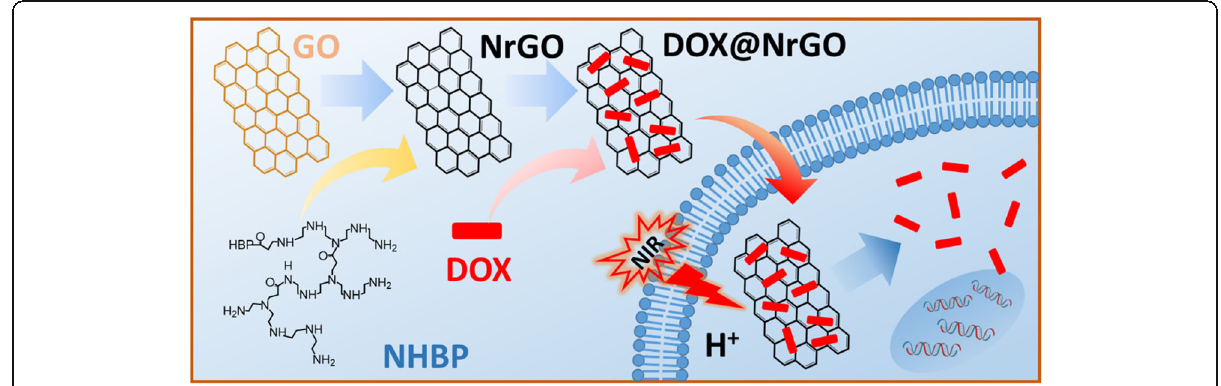
Fig. 1 Schematic illustration of preparation and chemo-photothermal therapy of